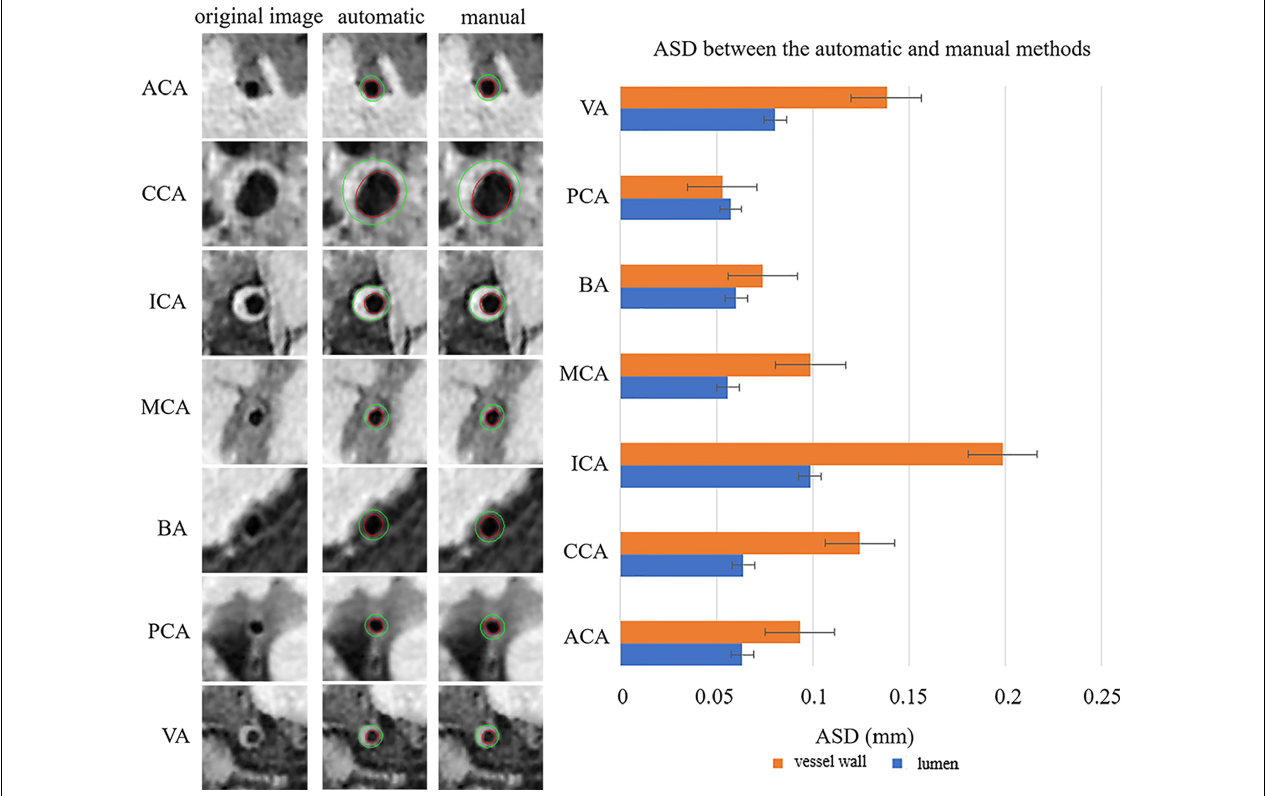
FIGURE 5 | Representative images and the ASDs between the automatic and manual methods for the seven arterial segments. On the left, the first column represents the original cross-sectional slices reconstructed from MR vessel wall images, the second column represents the automatically segmented lumen contour and outer vessel wall contour, and the third column represents the manual segmentation results of lumen and outer vessel wall contours of the seven arterial segments. The red contour represents the lumen, and the green contour represents the outer vessel wall. The ASDs of the seven arterial segments are shown on the right using a bar plot. The standard deviation (SD) represents the amount of dispersion of the variable and is calculated as the root square of the variance. ASD, average surface distance.